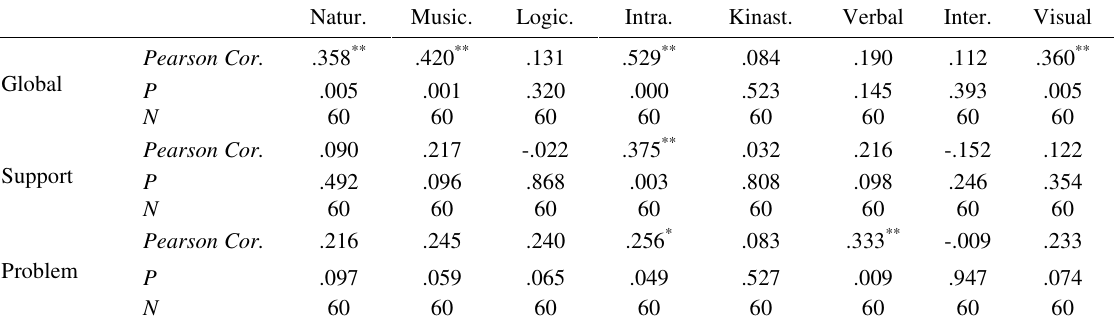
Table 4 Pearson Product Moment Correlations for Reading Strategies & MI Natur. Music. Logic. Intra. Kinast. Verbal Inter.